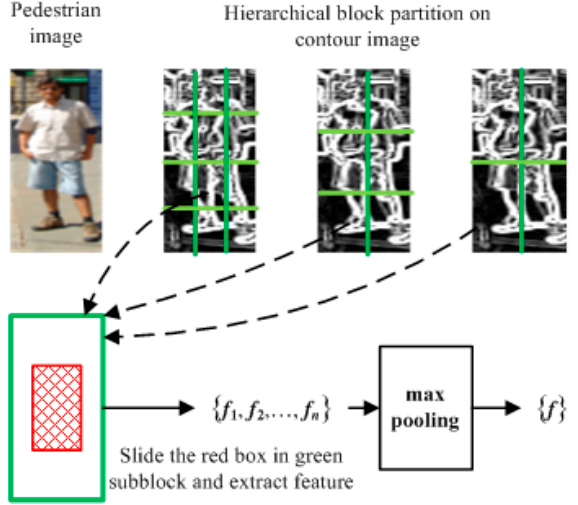
Figure 3. Illustration of proposed HFE.